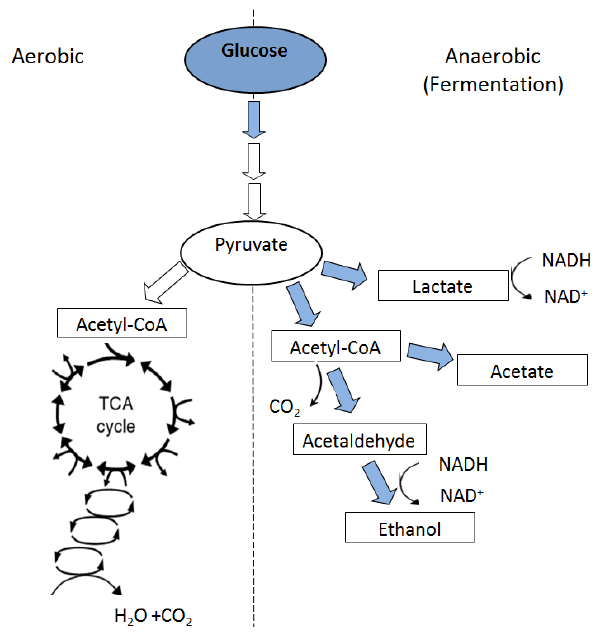
Figure 2. Metabolic pathways under aerobic and anaerobic conditions (from Reddy and DeLaune